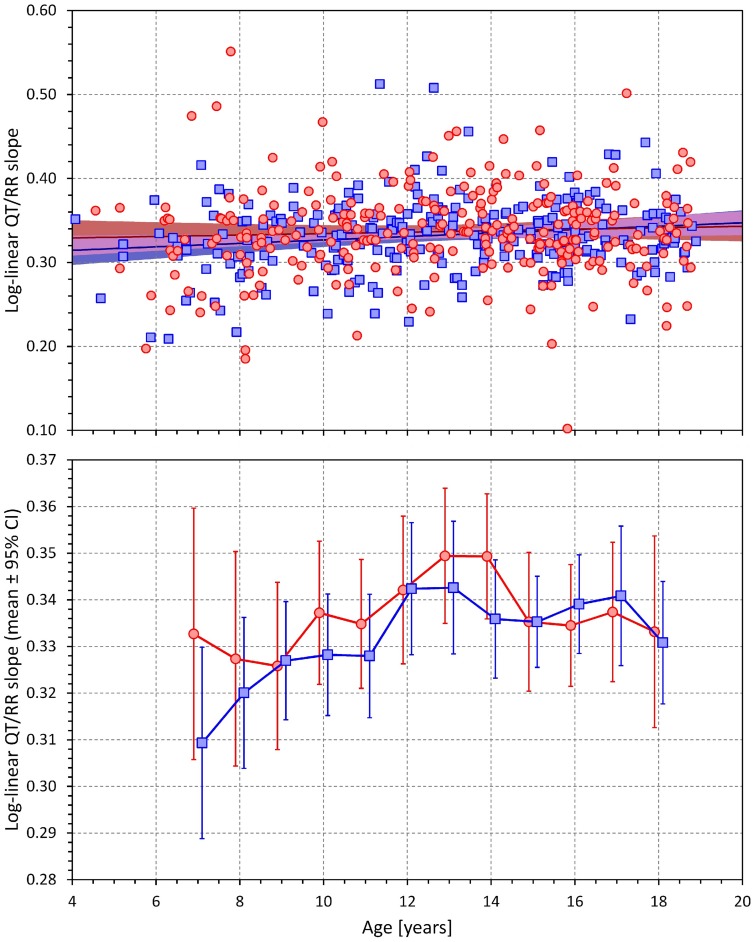
Age dependency of the slopes of the log-linear QT/RR regressions. The layout of the panels is the same as of the top two panels of Figure 6.